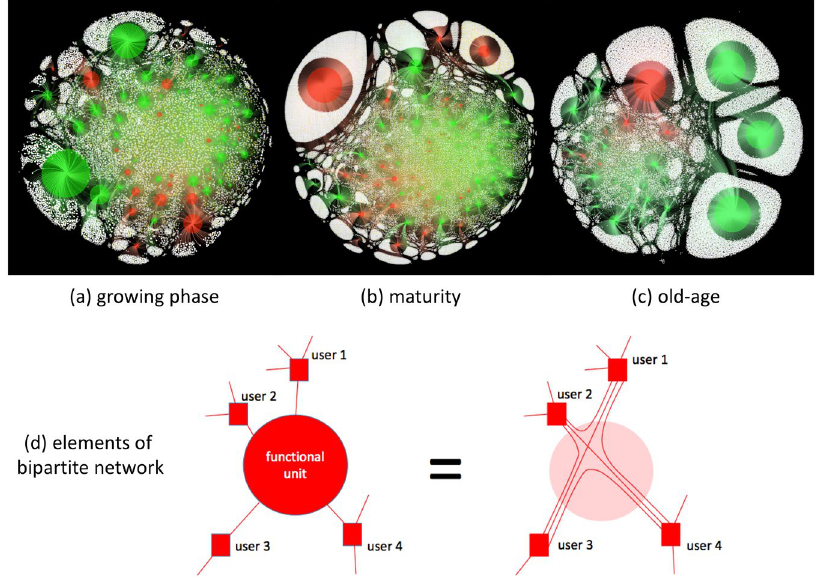
Figure 1. Organism network evolution. ( a ) Snapshots of the entire organism’s bipartite network during ( a ) growth (example from day 25), ( b ) maturity (from day 125) and ( c ) old-age approaching death (from day 315). Each user (i.e. smallest circles) in ( a – c ) can link into (i.e. follow) any number of functional units as shown schematically in ( d